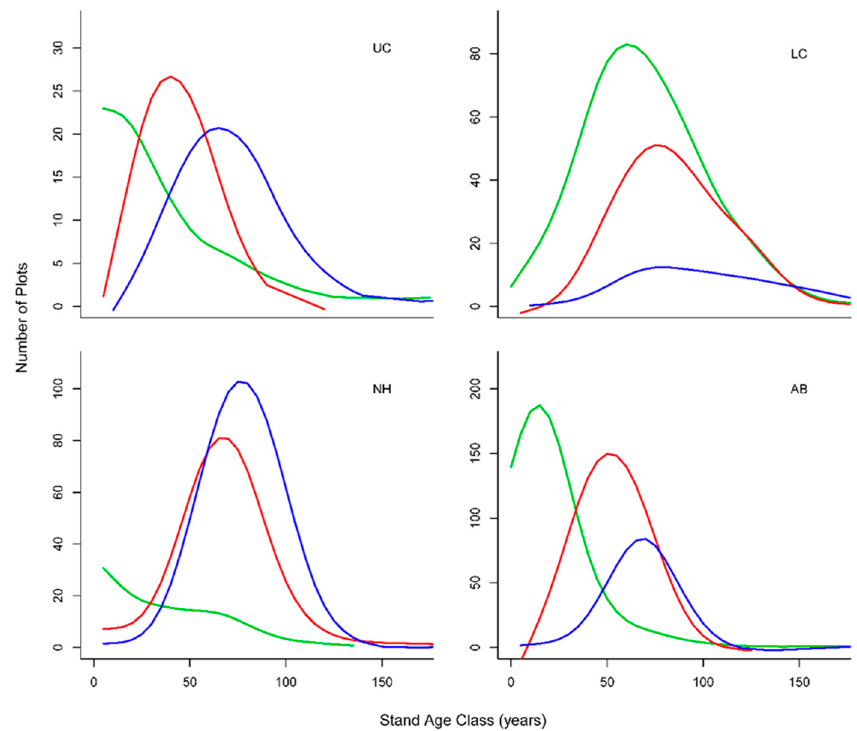
Figure 1. The distribution of size classes (seedling/sapling (green), poletimber (red), sawtimber (blue)) by age class for four forest type groups (upland conifer (UC), lowland conifer (LC), northern hardwoods (NH), and aspen-birch (AB)) in Minnesota. Data came from Forest Inventory and Analysis (FIA) records spanning 1999–2013. Due to considerable variation in the sample size, the y-axis units vary between graphs, but the x-axis units are identical. All curves were fit using a smoothing spline (with a smoothing parameter equal to 0.6).